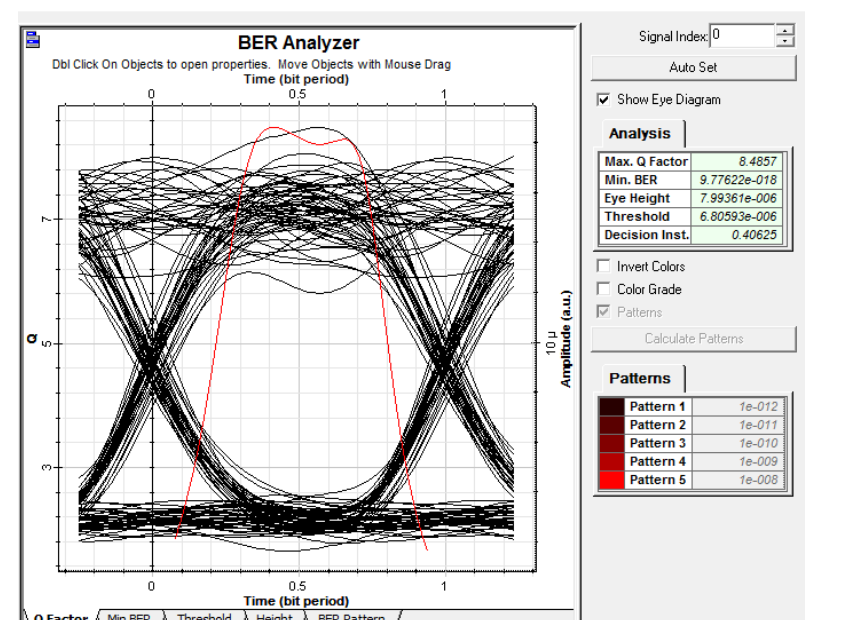
Fig. 8 Eye diagram showing BER performance on moderate dust 32 dB/km of two channels and EDFA FSO system at 2.3